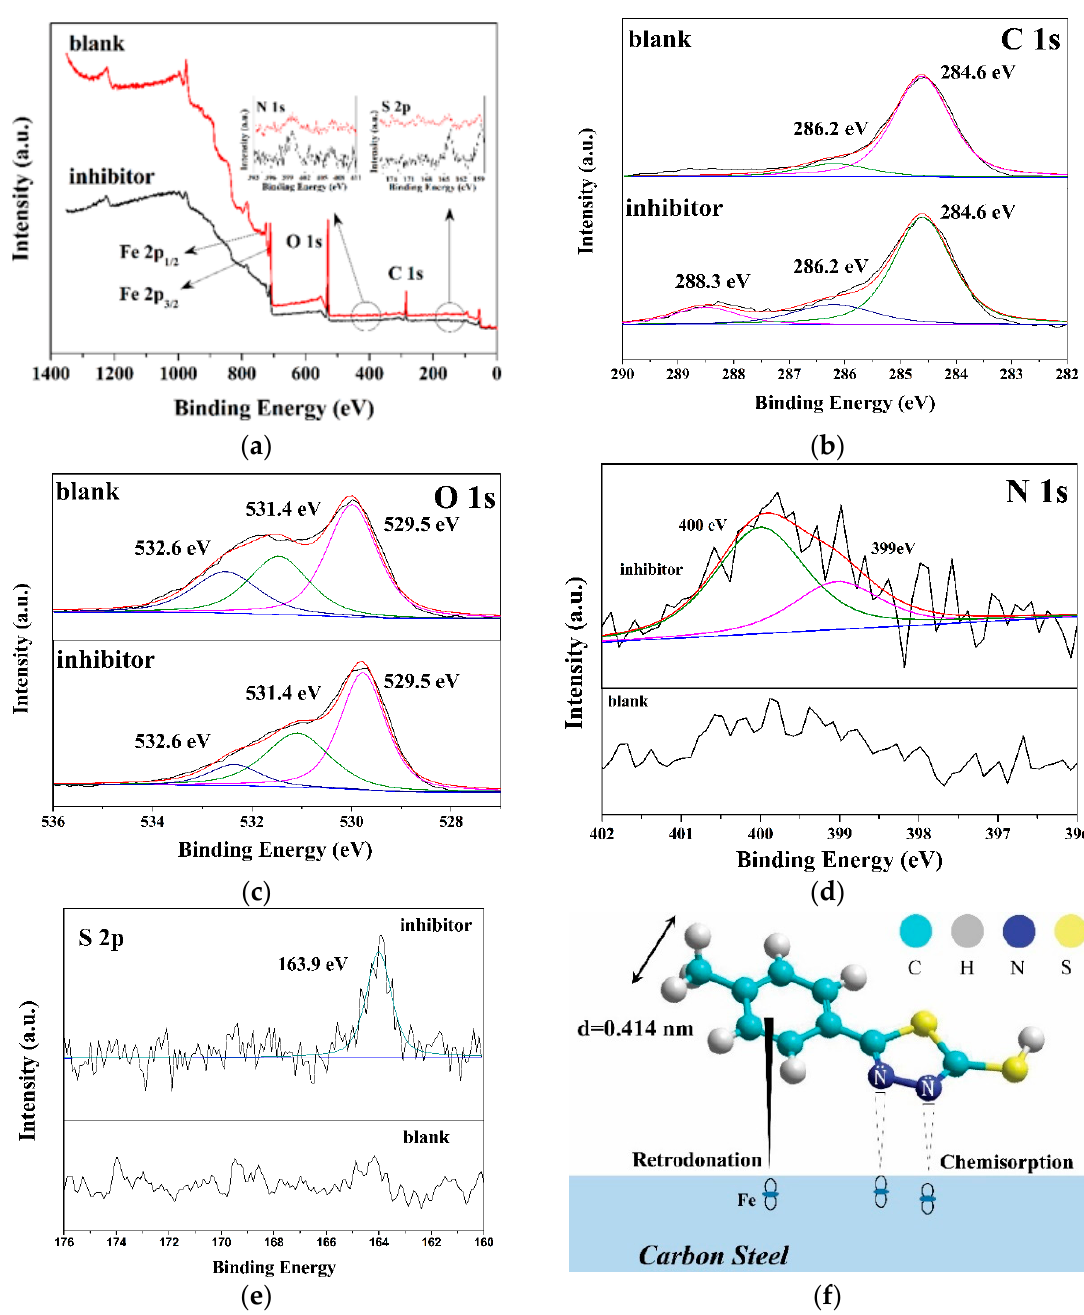
Figure 4. XPS spectra of ( a ) total spectra; high-resolution spectra of ( b ) C 1s, ( c ) O 1s, ( d ) N 1s, and ( e ) S 2p peaks; ( f ) schematic of inhibitor adsorbed on carbon steel surface.